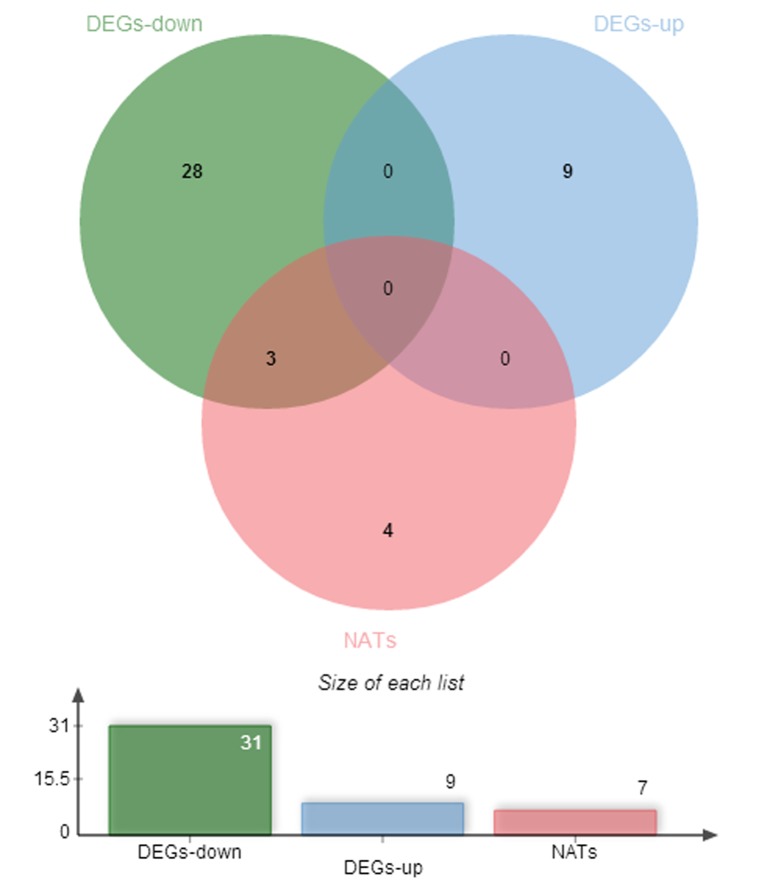
The numbers of DEGs between two groups.Between two groups, there were 9 upregulated genes and 31 downregulated genes and 7 NATs.